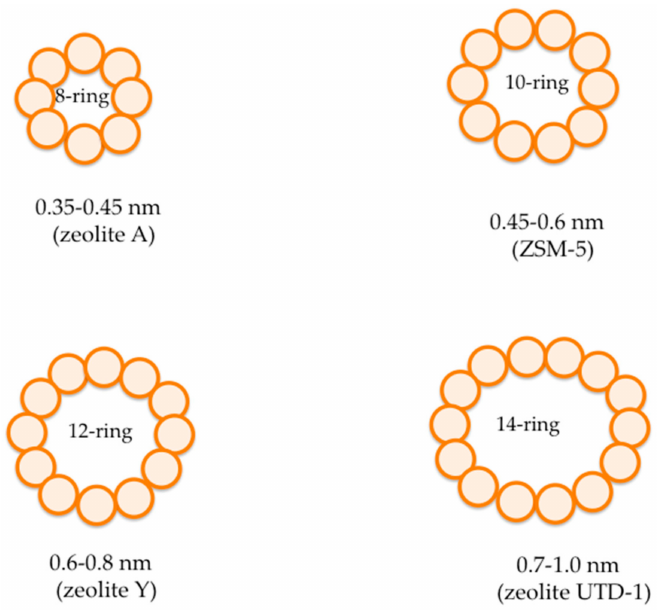
Figure 4. General drawing of typical zeolite pore sizes with oxygen packing models. Adapted from Flanigen et al.